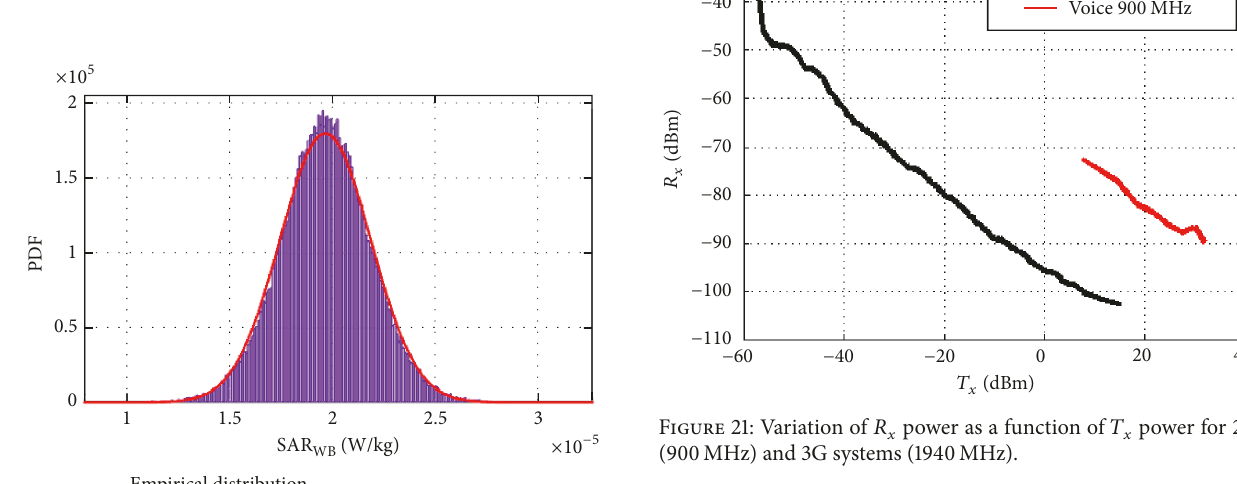
induced by 10 5 realizations. WB